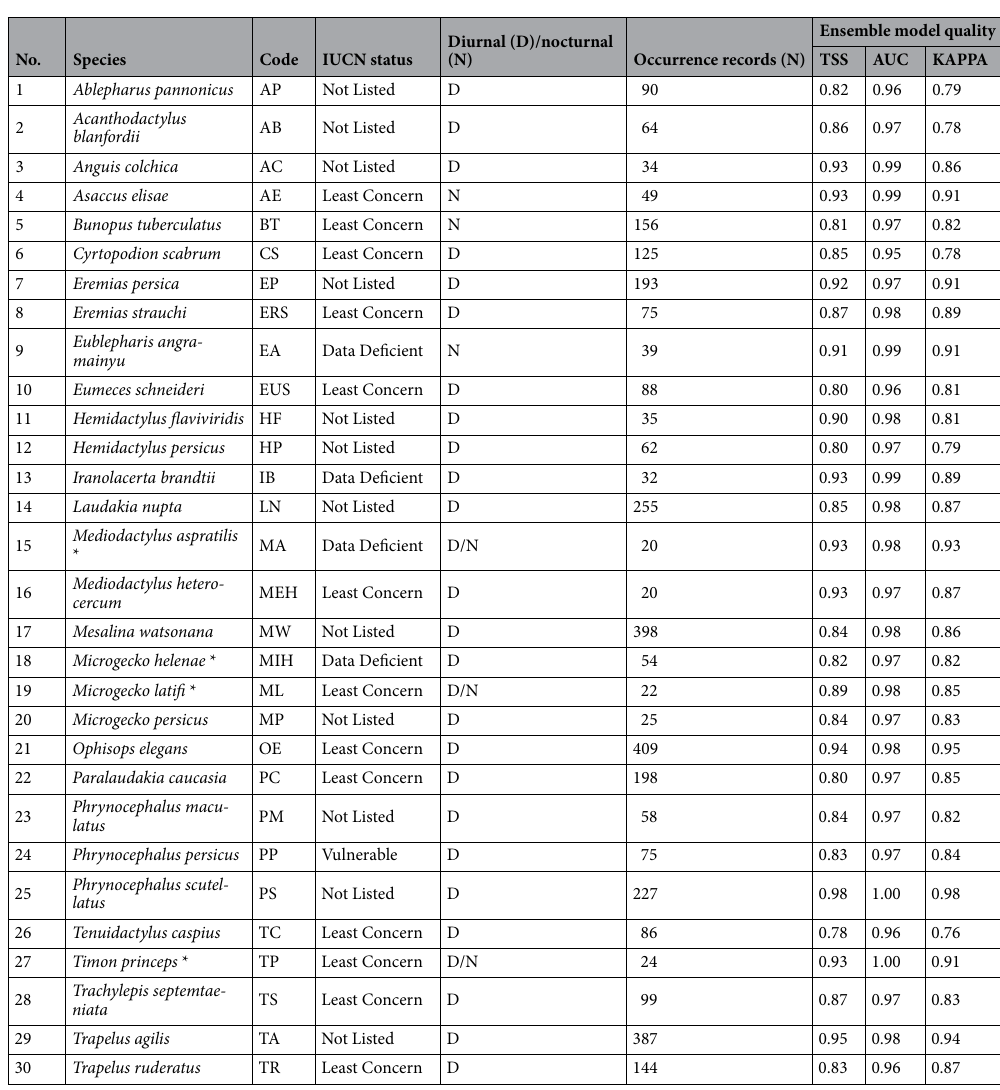
Table 1. Lizard species list, codes, conservation status under IUCN criteria, diurnal (D) or nocturnal (N) activity, number of occurrence records (N), and ensemble model quality. *Endemic to